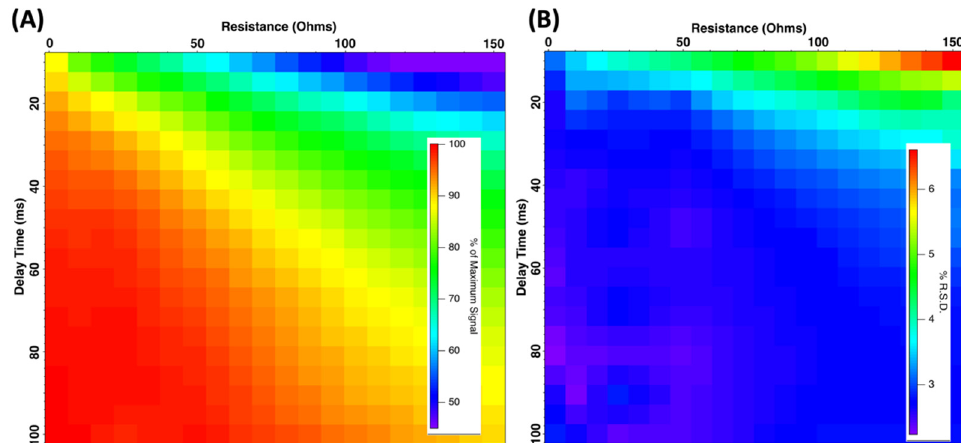
Figure 3. ( A ) Image plot of resistance of external LED resistor resistance vs. software programmed delay time between pulses vs. LED signal. The color indicates LED brightness (signal). ( B ) Image plot of resistance of external LED resistor resistance vs. software programmed delay time between pulses vs. percent relative standard deviation (% R.S.D.) of LED pulses. The color indicates % R.S.D. of sequential LED pulses.